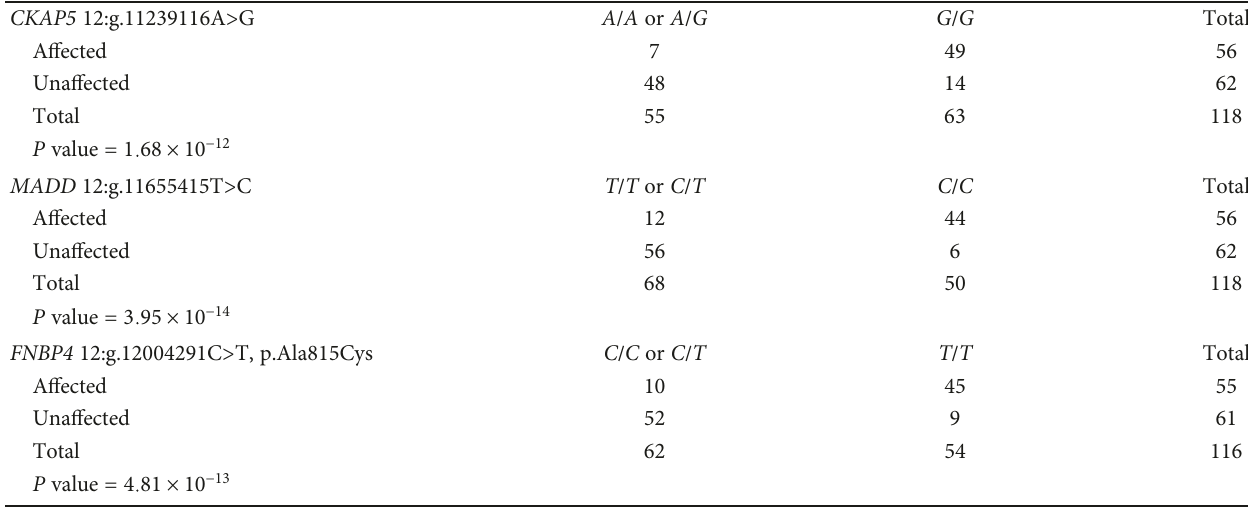
Figure 2: Association testing of variants identi fi ed from analysis of resequencing data in Ha fl ingers phenotyped for ocular SCC. The DDB2 variant (c.1013 C > T ) was the most concordant with ocular SCC phenotype in a population of 118 Ha fl ingers (56 cases and 62 controls). Other variants that were strongly associated but less concordant with ocular SCC phenotype include 12:g.11239116A > G (CKAP5), Table 6: Association between ocular SCC a ff ection status and CKAP5 12:g.11239116A > G, MADD 12:g.11655415T > C, and FNBP4 12:g.12004291C > T